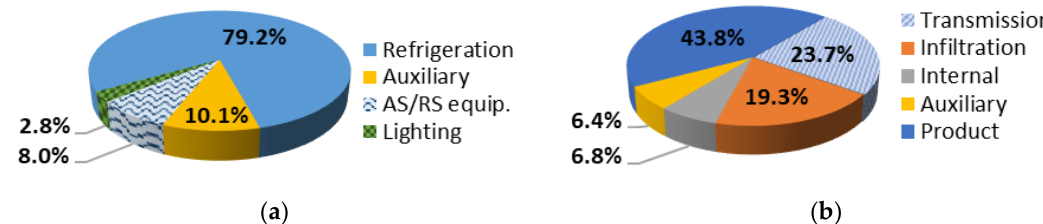
Figure 4. ( a ) Electricity demand structure and ( b ) refrigeration load structure of the reference case.